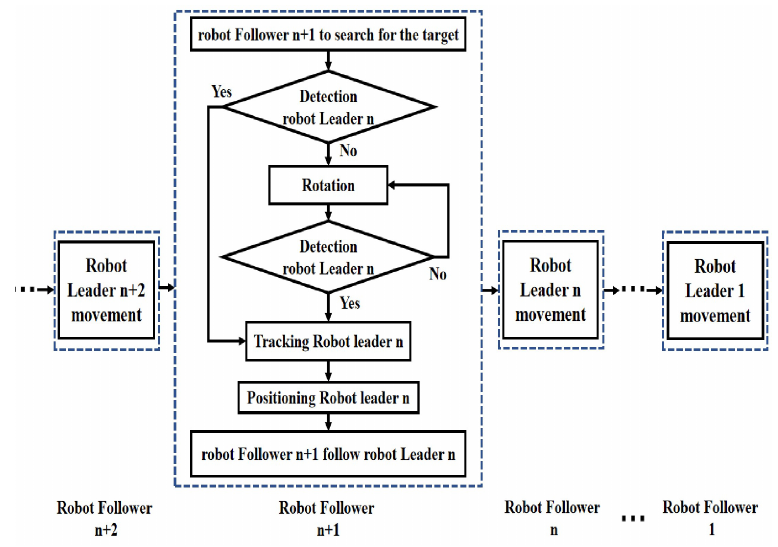
Figure 6. The flow chart of the actions taken by the